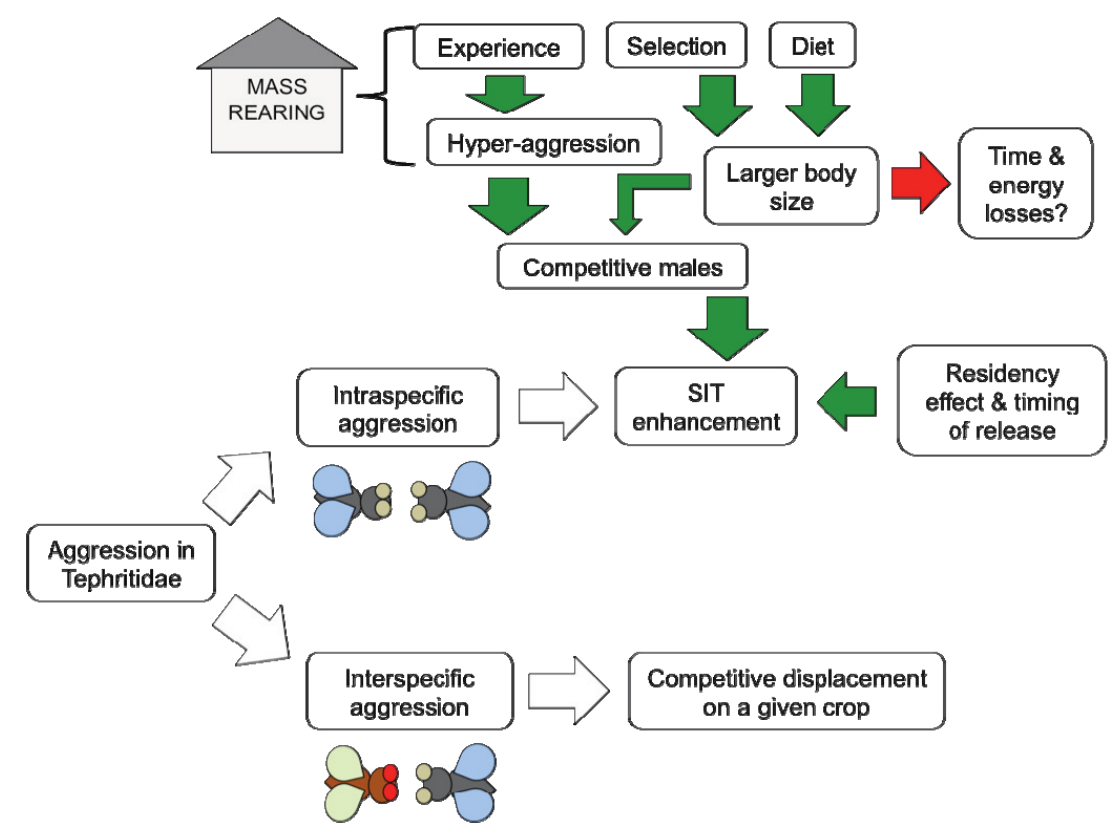
Figure 2. How knowledge on aggressive behavior in Tephritidae flies may be exploited to enhance behavior-based control tools. Dynamics beneficial to pest control are the green arrows, while detrimental mechanisms are the red